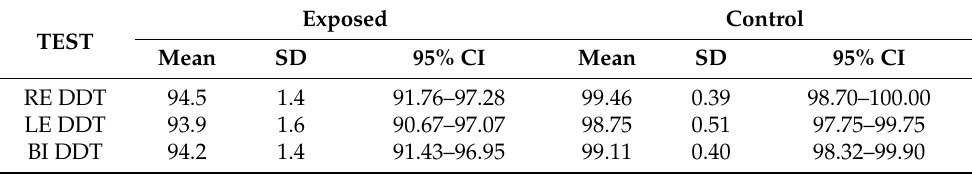
Table 5. Dichotic digits test results for the exposed and control